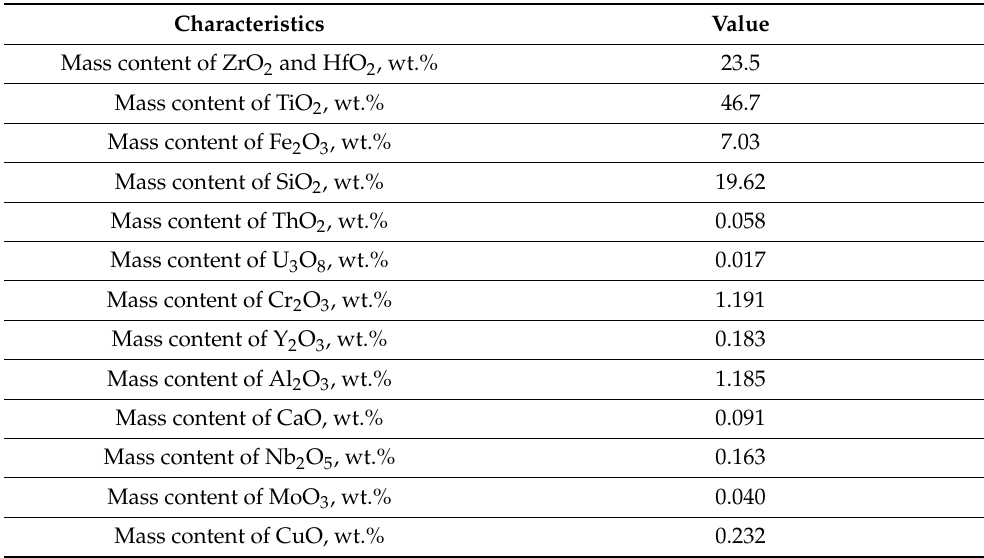
Table 12. Chemical composition. Characteristics Value Mass content of ZrO 2 and HfO 2 , wt.% 23.5 Mass content of TiO 2 ,